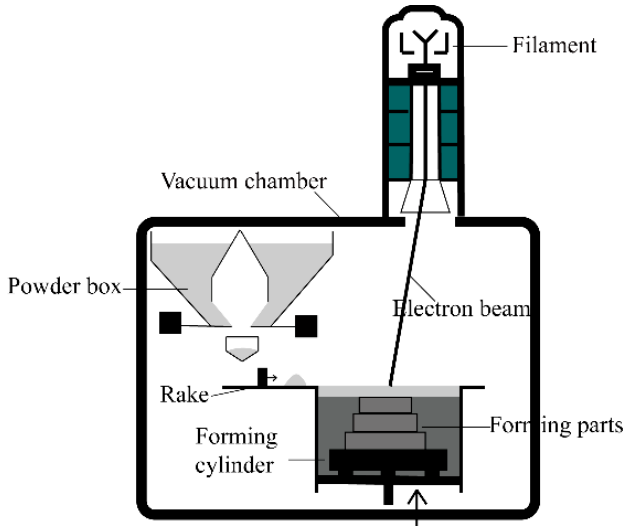
Figure 8. Schematic diagram of EBM system.